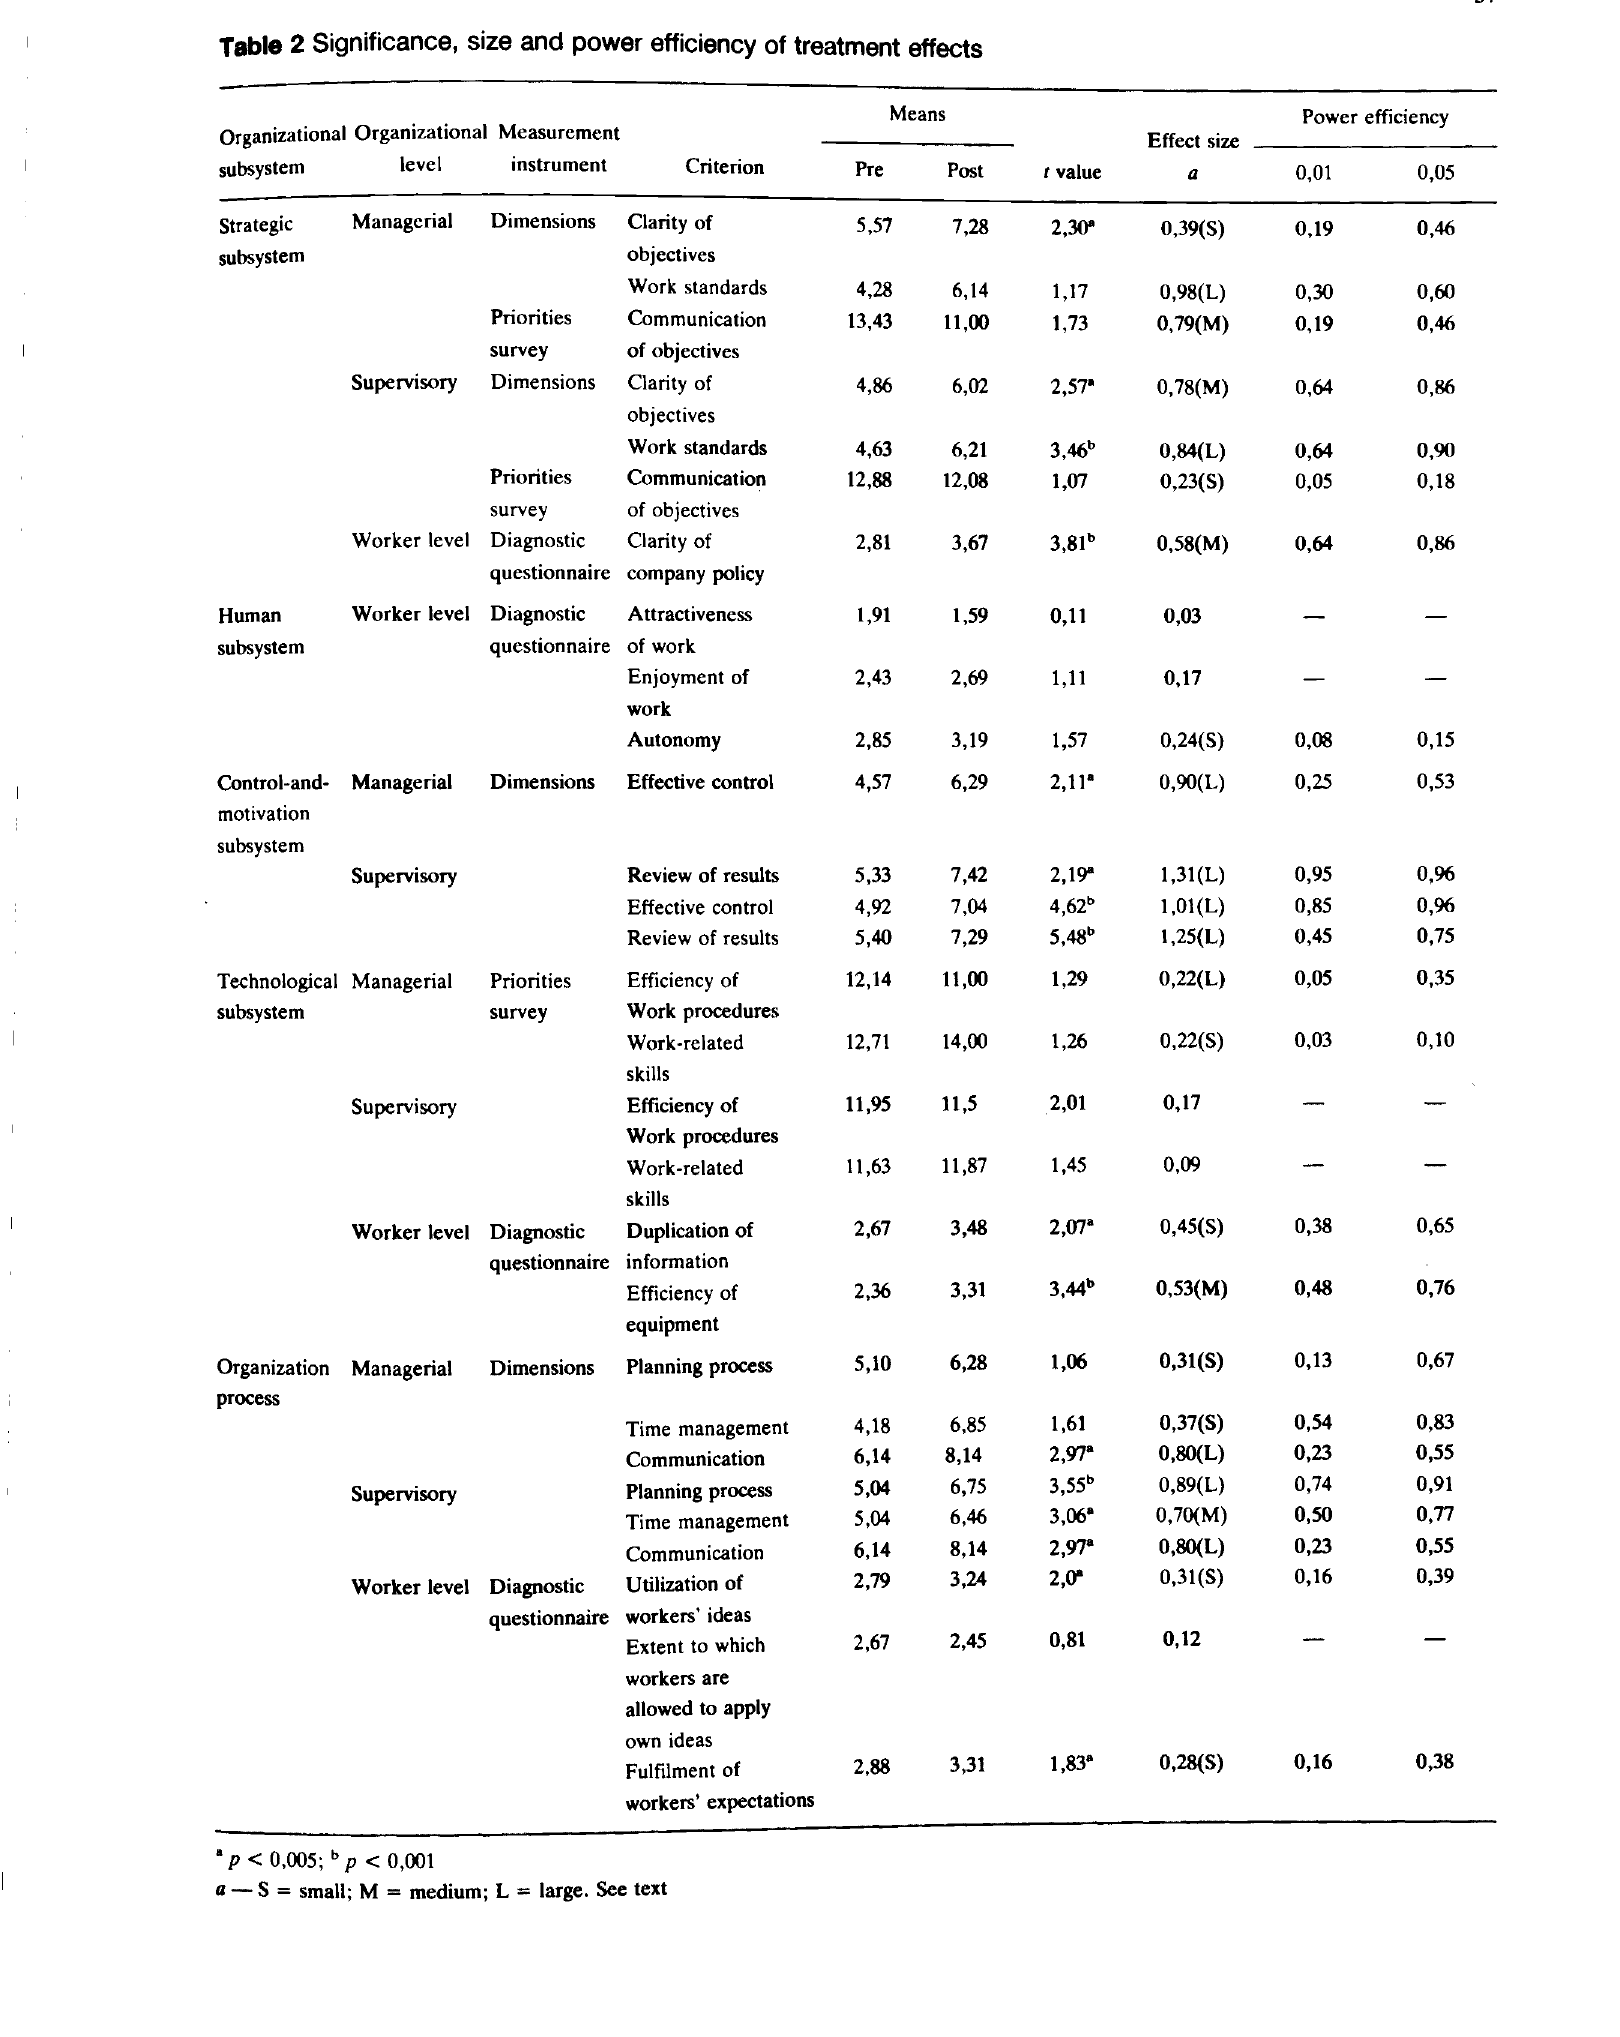
Table 2 Significance, size and power efficiency of treatment